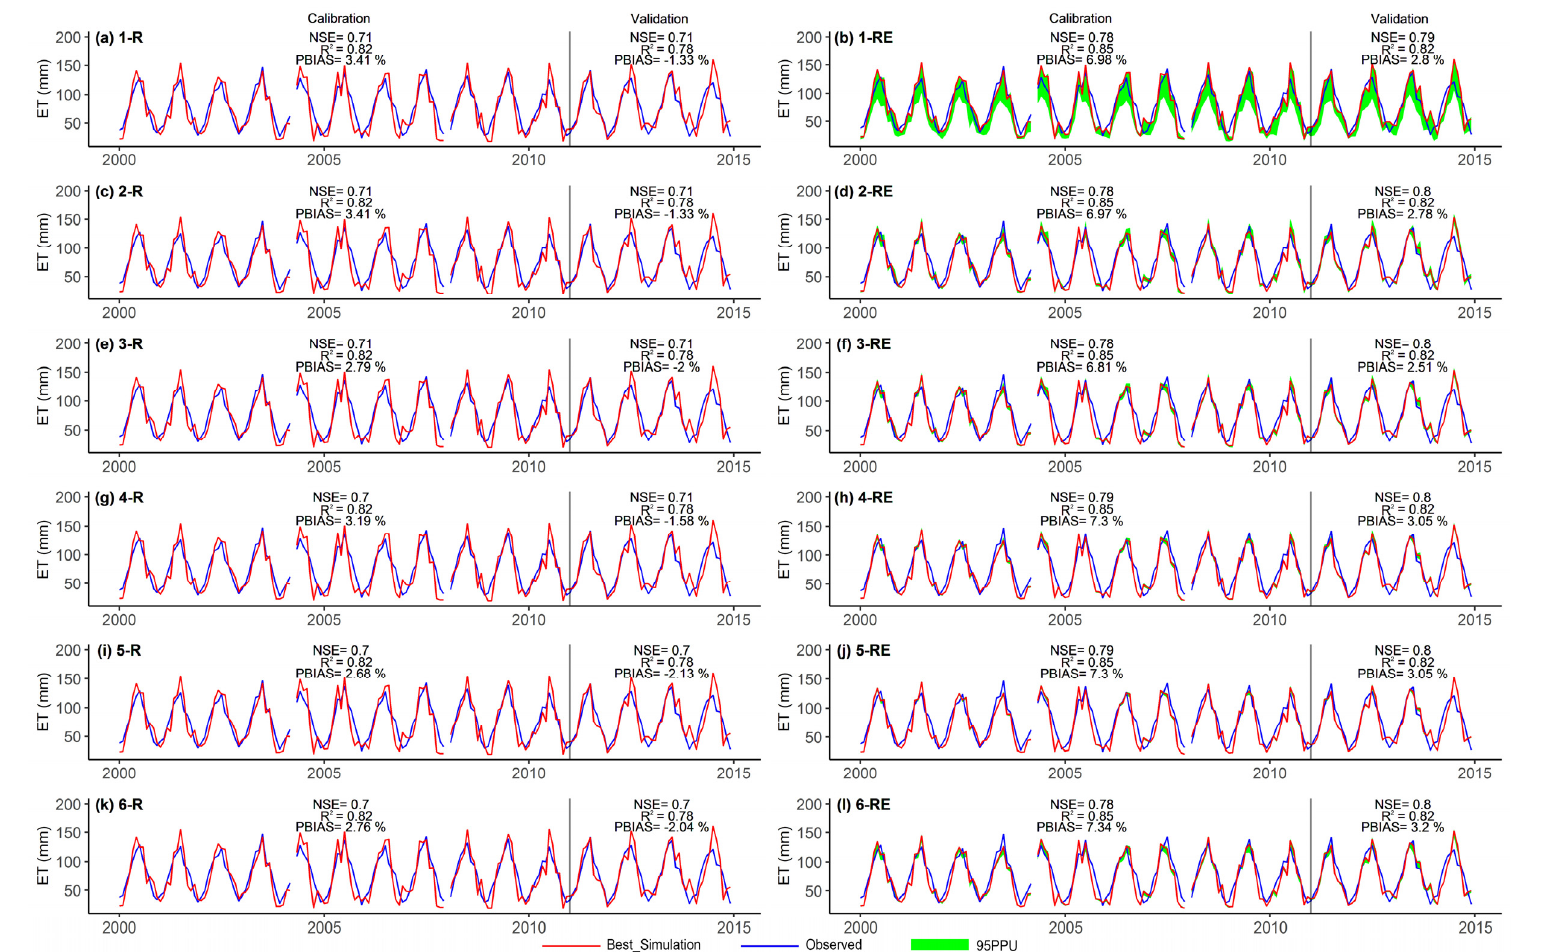
Figure 5. Model performance in simulating the spatially averaged evapotranspiration using different methods. The left panel was the simulated ET using the best parameter sets of single-variable (streamflow) calibration. The right was the output of multi-variable (streamflow plus ET) calibration. The definition of scenario codes (e.g., 1-R, 1-RE, etc.) marked on the upper left corner of each panel can be referenced to Table 2. ( a – l ) were the codes of 12 scenarios.